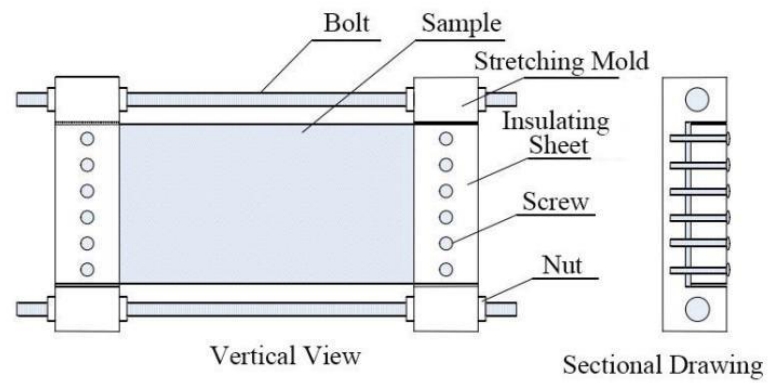
Figure 2. Tensile fixing